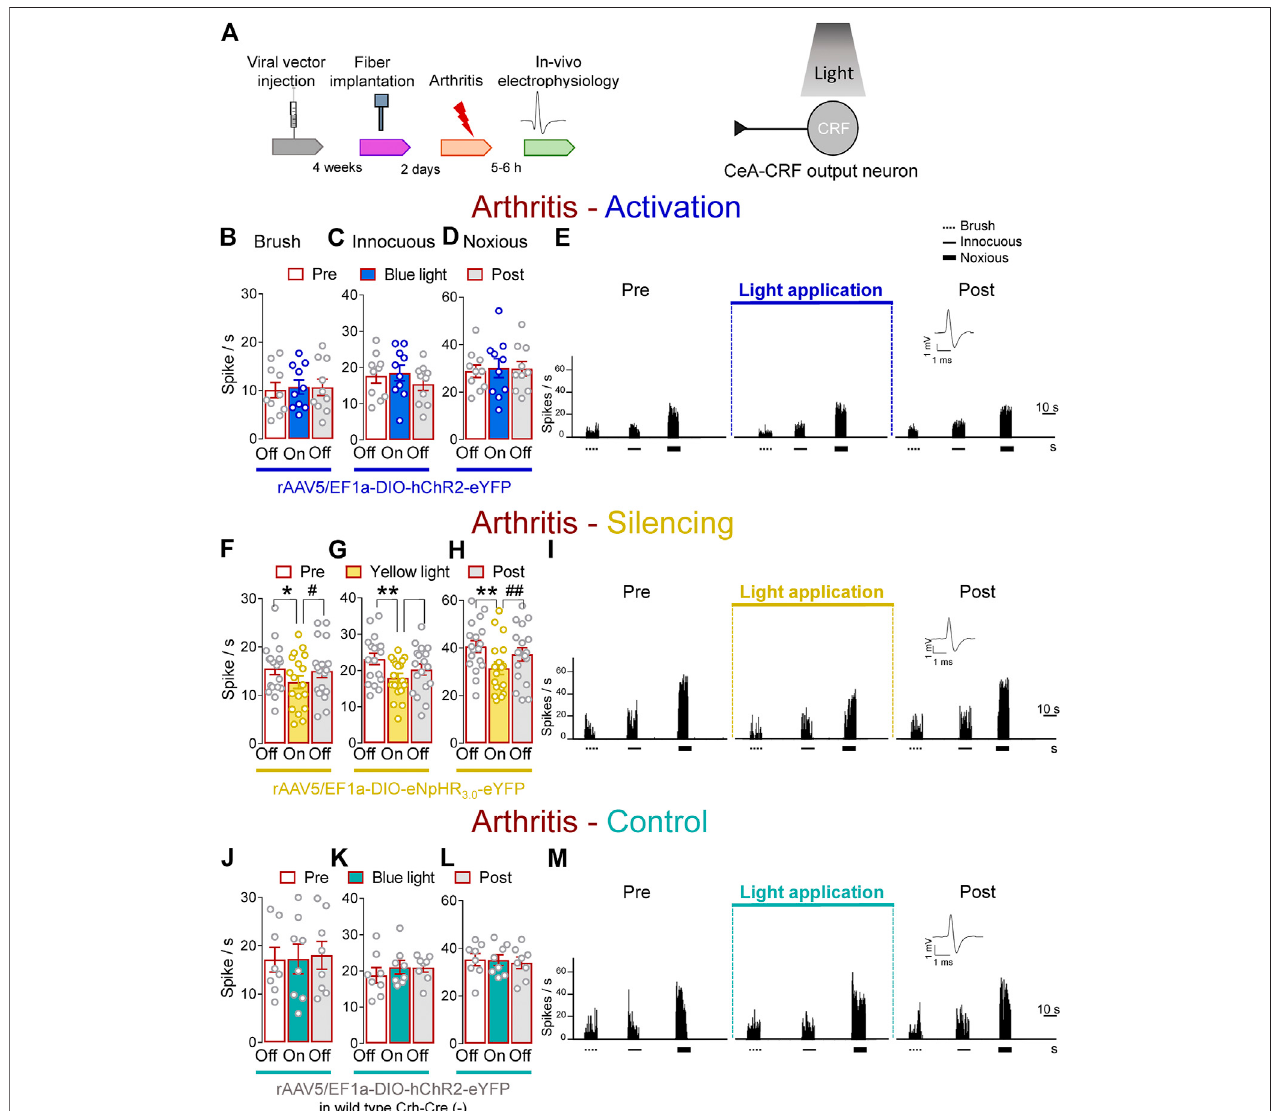
FIGURE 5 | Optogenetic silencing of CeA-CRF neurons in the arthritis pain model reduces the increased activity of spinal cord neurons. (A) Experimental design. Responses of WDR neurons ( n (cid:1) 10) to brushing the skin (B) and innocuous (C) and noxious (D) compression of the left knee joint were not signi fi cantly affected by optical activation of ChR2 expressing CeA – CRF neurons with blue (473 nm) light ( “ On ” , 20 Hz, 5 mW, 5 – 10 min) compared to no light ( “ Off ” ) values in arthritic rats. (E) Peristimulus time histograms (500 ms bin size) of a single WDR neuron recorded before, during and after blue (473 nm) light application (20 Hz, 5 mW, 5 – 10 min) in an arthritic rat. Bar histograms show means ± SEM. (F – H) Same display as (B – D) but for silencing of eNpHR 3.0 expressing CeA – CRF neurons with yellow (590 nm)light( “ On ” ). (I) Samedisplayas (E) butforCeA – CRFneuronsilencing( n (cid:1) 18).*,** p < 0.05,0.01comparedtonolight( “ Off ” )values; p < 0.05,0.01comparedto light( “ On ” ) values,repeatedmeasuresone – way ANOVA withBonferroniposthoc tests. (J – L) Samedisplay as (B – D) but inwildtype controlratswithblue(473 nm)light ( “ On ” ) application ( n (cid:1) 8). (M) Same display as ( E) but in a wild type control rat.